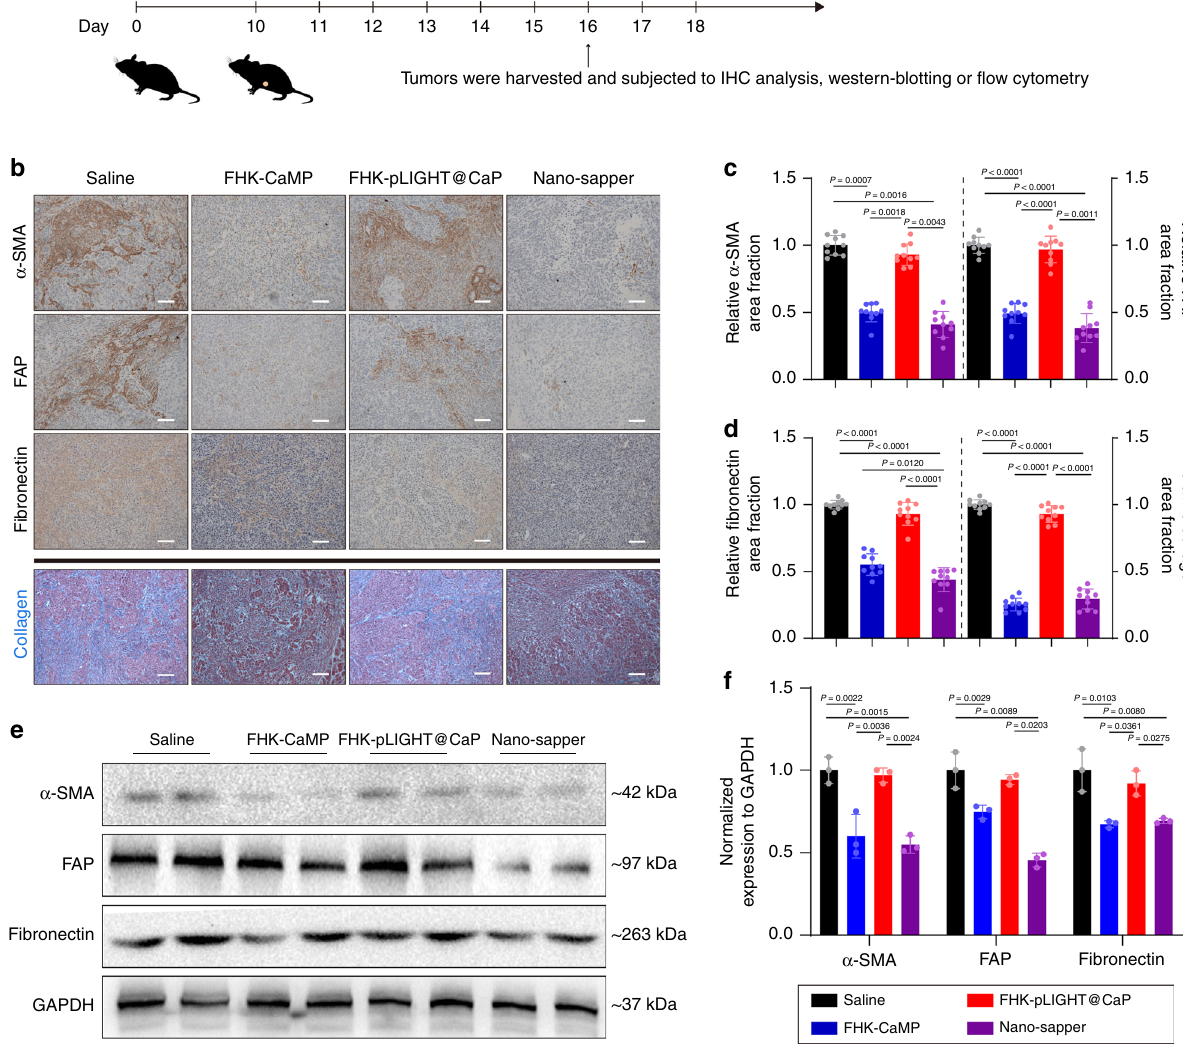
Fig. 3 Nano-sapper reversed CAFs activation and reduced stromal composition in PDAC. a Six-week-old male C57BL/6 mice were orthotopically inoculated with KPC1199 cells (1 × 10 6 ) on day 0. Saline, FHK-CaMP (MP = 13.9 mg/kg), FHK-pLIGHT@CaP (25 μ g plasmid per mouse) and Nano-sapper (MP = 13.9 mg/kg, 25 μ g plasmid per mouse) were i.v. administered on day 11, 13, and 15. On day 16, tumors were harvested for analysis. b – d Tumor slices were stained for α -SMA, FAP, fi bronectin and collagen, and analyzed by ImageJ. Scale bars, 100 μ m ( n = 10 section images from three mice). Data were pooled from three independent experiments. e , f Tumors were lysed to detect expression of α -SMA, FAP and fi bronectin ( n = 3 mice). Data were pooled from three independent experiments. Data are presented as mean ± s.d. One-way ANOVA with Bonferroni multiple comparisons post-test was used for ( c ), ( d ), and ( f ). Error bars represent s.d. Source data of ( e ) are provided as a Source Data fi